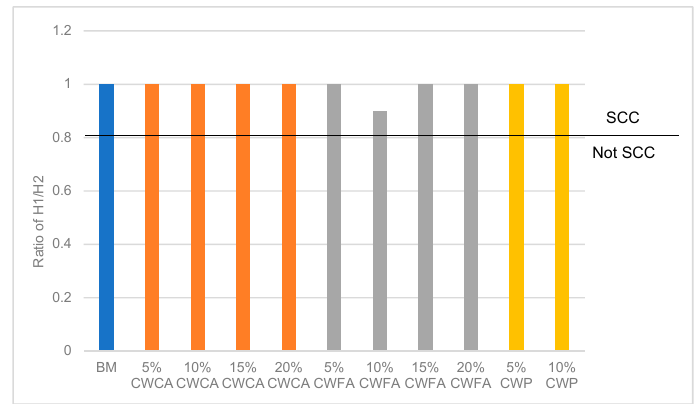
Figure 5. Ratio of H2/H1 obtained from the L-Box Test results for SCC samples containing varying dosages of CWCA, CWFA, and CWP.